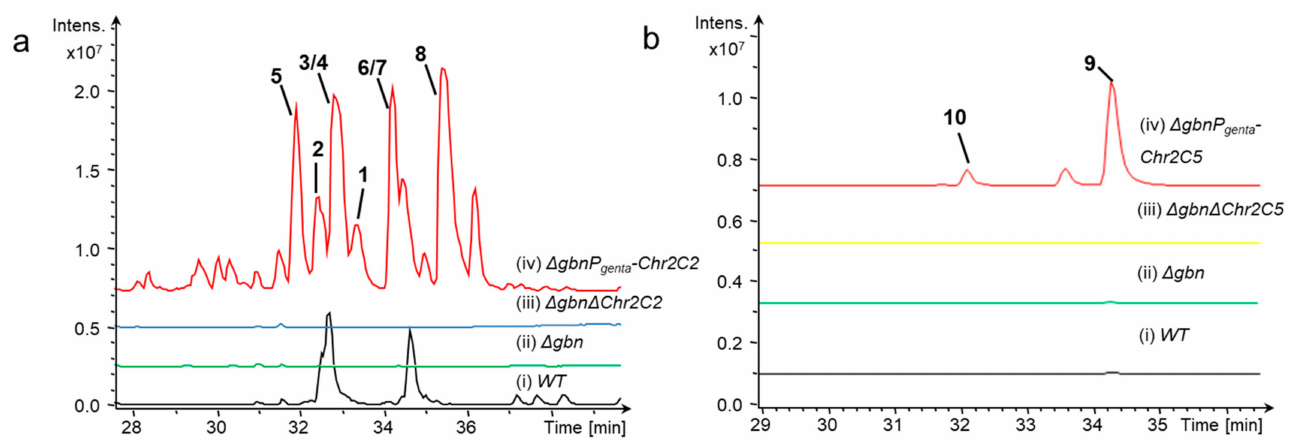
Figure 3. Mining of two silent biosynthetic gene clusters in B. gladioli ATCC 10248. ( a ) HPLC–MS analysis (BPC 700–1200) of crude extracts from wild type and mutants. ( b ) HPLC-MS analysis (BPC 474, 807) of crude extracts from wild type and